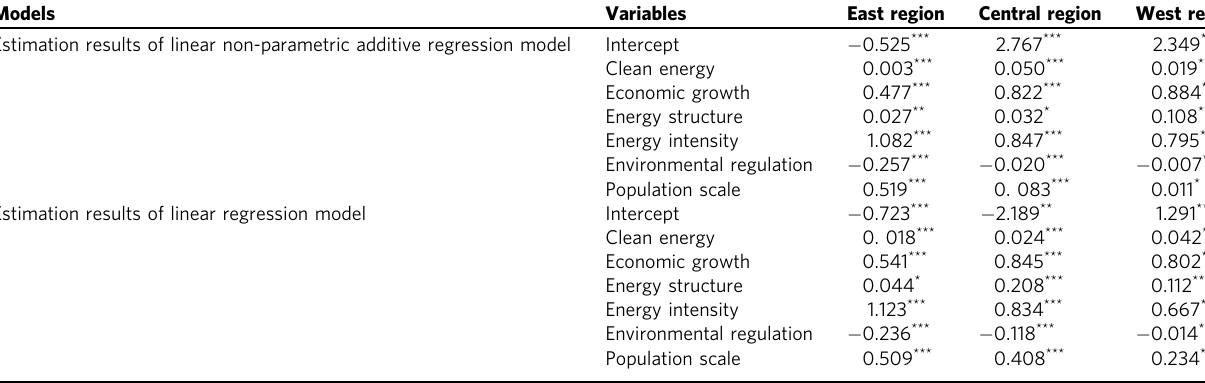
Table 6 The linear impact of CED on regional CDE.